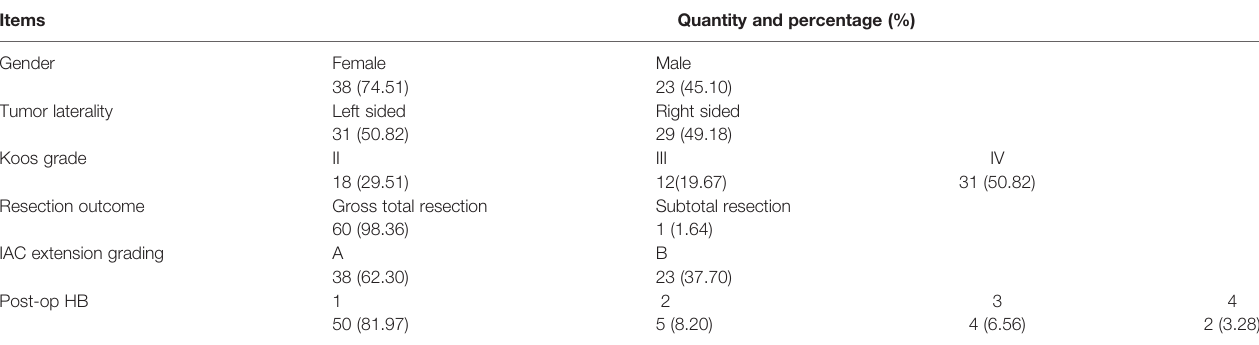
TABLE 1 | Basic information of patients involved in this